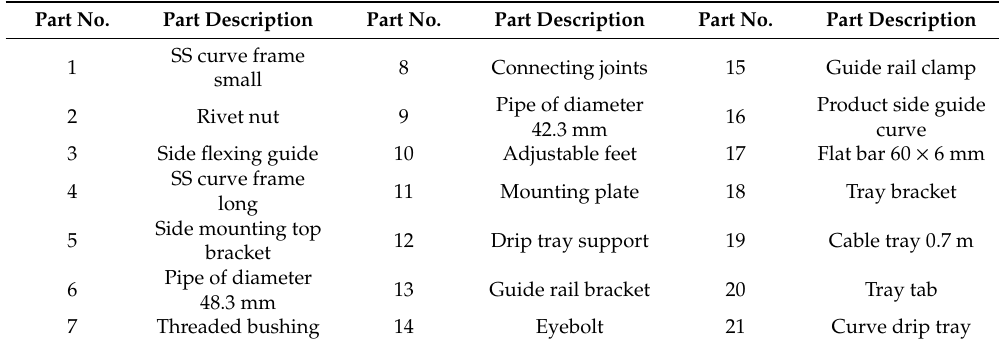
Table 3. Parts description for ’90-degree curve